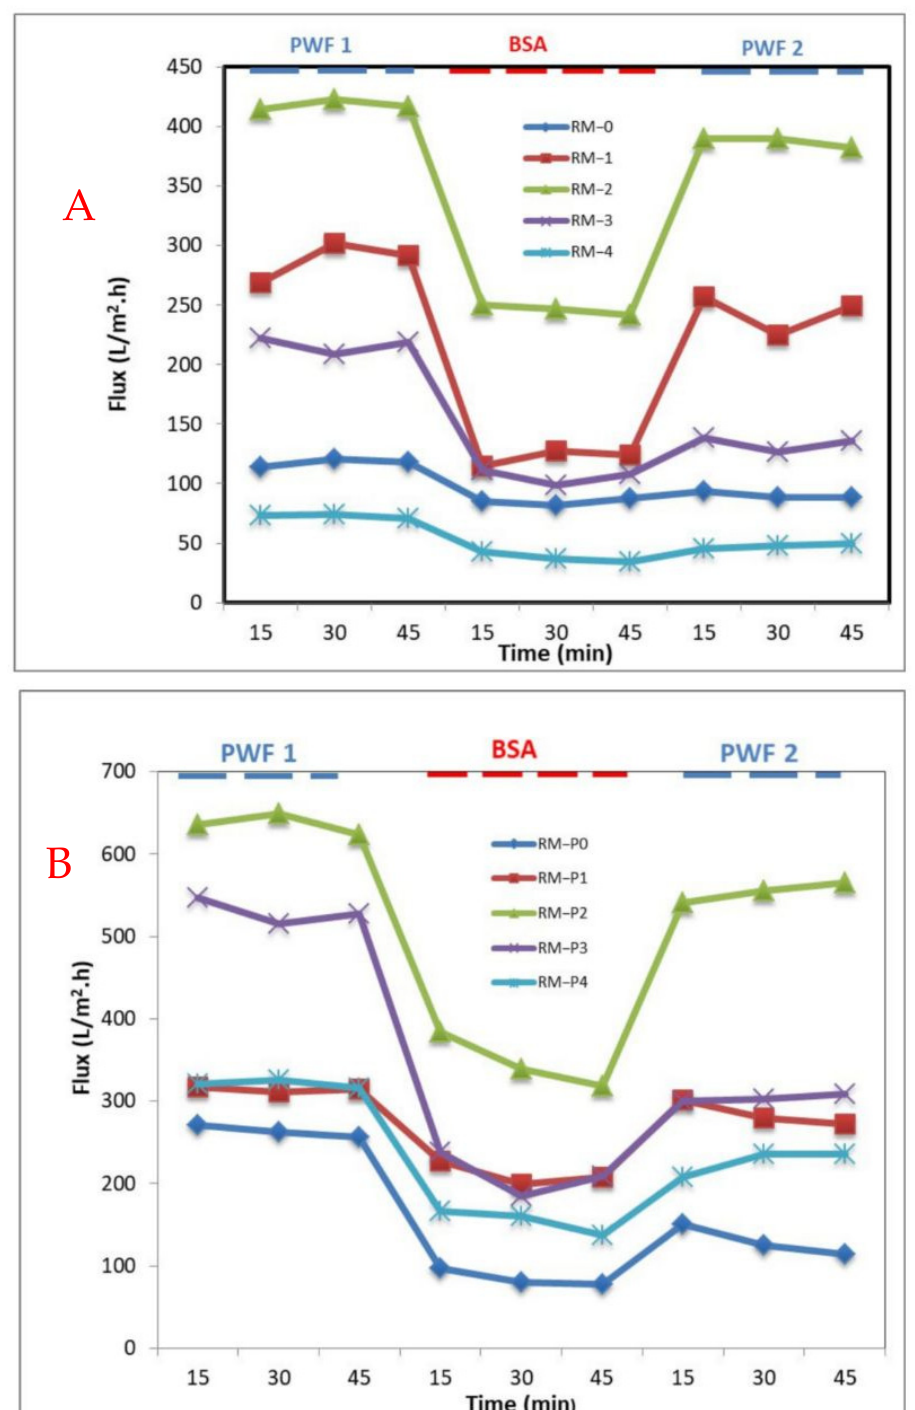
Figure 11. Time − dependent water permeation fluxes during the fouling processes with various wt.% of GO − WO 2.89 for ( A ) PPSU membrane and ( B ) PPSU/PVP membrane.